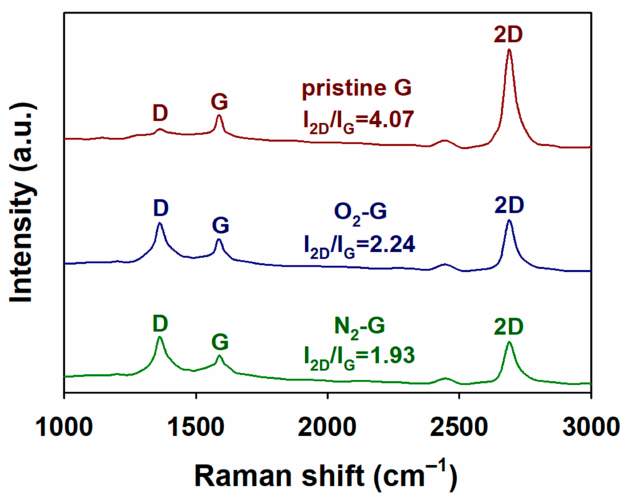
Figure 3. Raman spectra of pristine G, O 2 -G and N 2